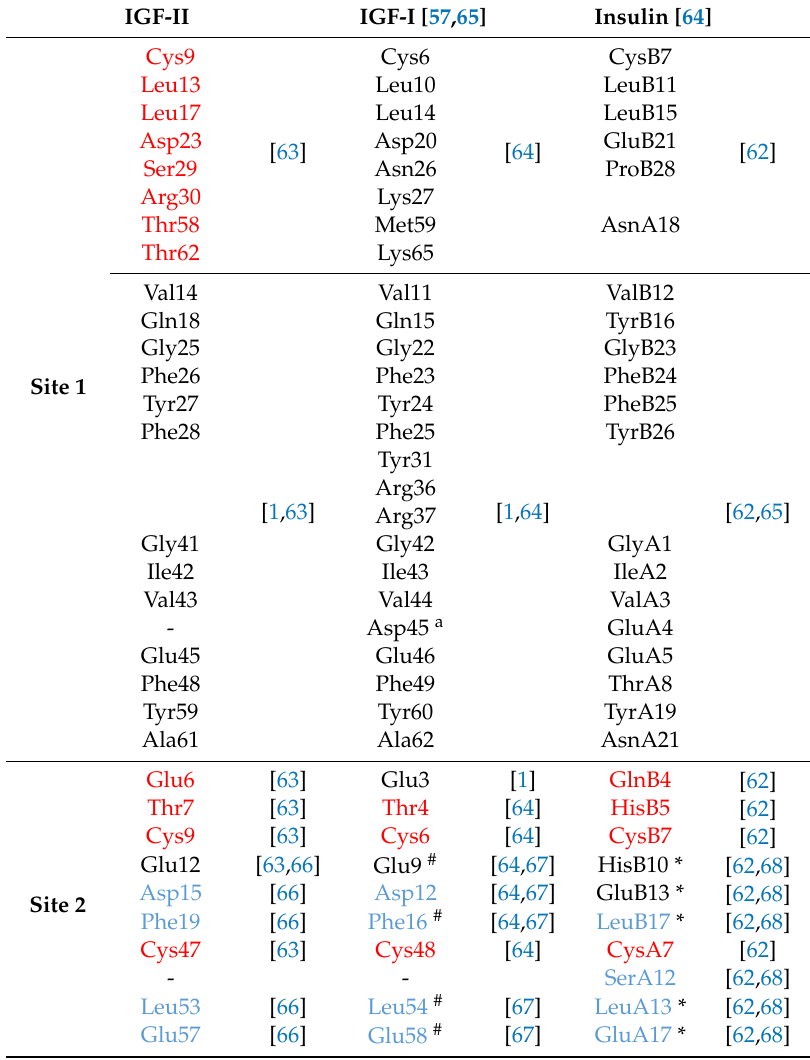
Table 1. Binding site 1 and 2 residues of insulin, IGF-I and IGF-II. Residues identified as contacting the receptor through mutagenesis studies (coloured blue), structural studies (red) or both (black). * Residues observed to make transient contact with the FnIII-1 domain of IR [64]. # Residues observed to make transient contact with the FnIII-1 domain of IGF-1R [57]. a Asp45Ala IGF-I mutant results in 3-fold decrease in binding a ffi nity